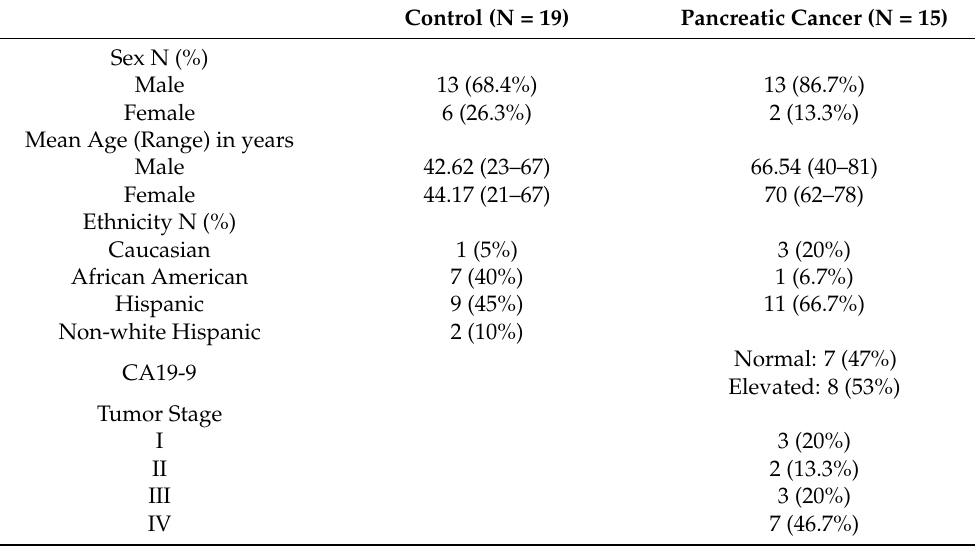
Table 1. Patient information obtained from 19 control donors and 15 pancreatic cancer